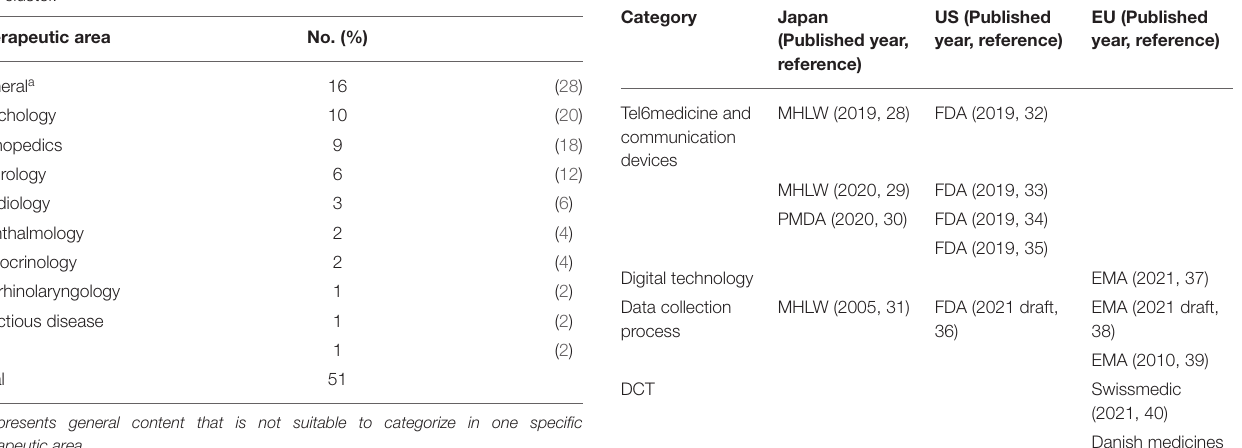
TABLE 5 | Guidelines for utilization of IoMT/IoHT in clinical trials or DCT.